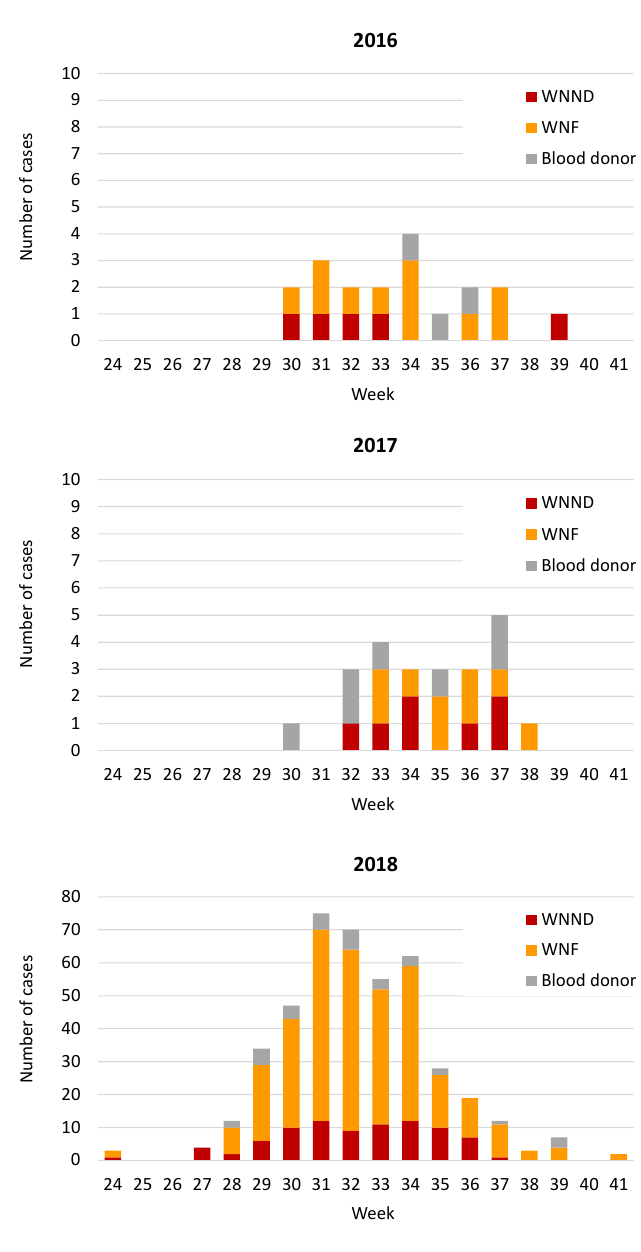
6 of 14 Figure 1. Incidence of WNV disease (i.e., West Nile neuroinvasive disease and West Nile fever), incidence of West Nile neuroinvasive disease, and incidence of West Nile fever according to age and sex, Veneto region, northern Italy, 2018. Data on the population resident in the Veneto region were obtained from ISTAT (Italian Institute of Statistics, www.istat.it). In 2018, there was an anticipation and a longer duration of the WNV transmission period than in previous years (Figure 2). In particular, the first human case of WNV infection developed symptoms of encephalitis in mid-June and the last case developed symptoms in mid-October. The largest number of cases of infection occurred between mid-July and mid-August, with a peak during the last week of July. The total number of West Nile cases identified in the Veneto region in 2018 was 20-fold higher